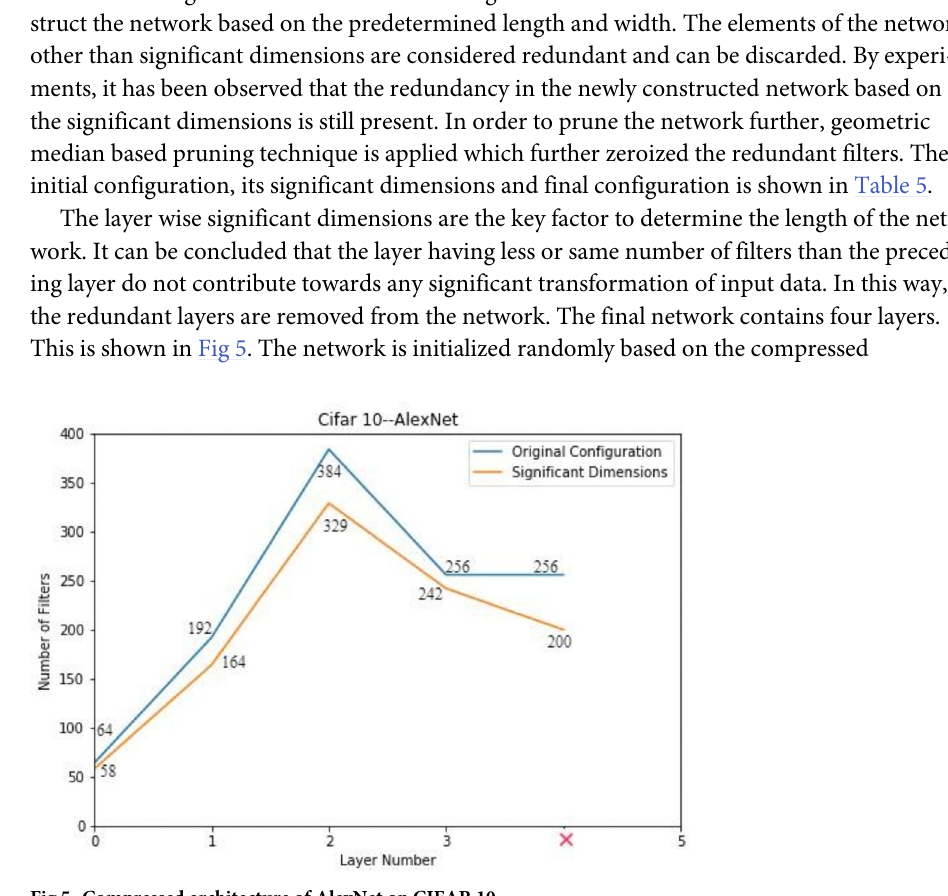
Fig 5. Compressed architecture of AlexNet on CIFAR